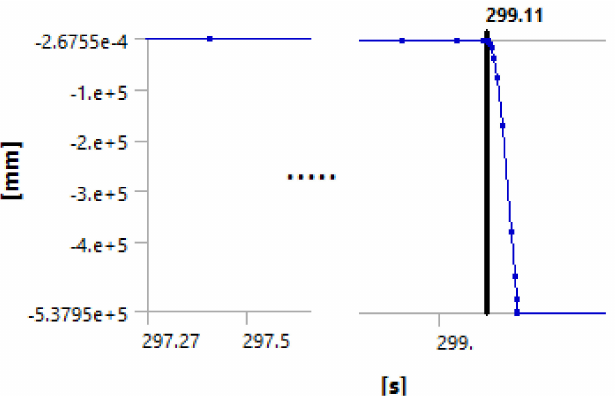
Figure 8. Debonding moment observed on the axial displacement plot showing abrupt change of displacement by the blue line at time stamp 299.11 s.